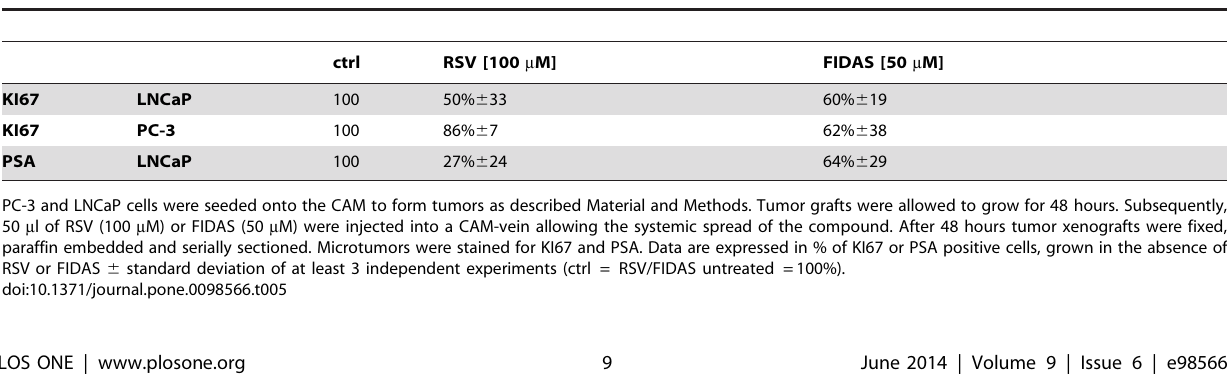
Table 5. Effects of RSV and FIDAS on on PCa cells in vivo .